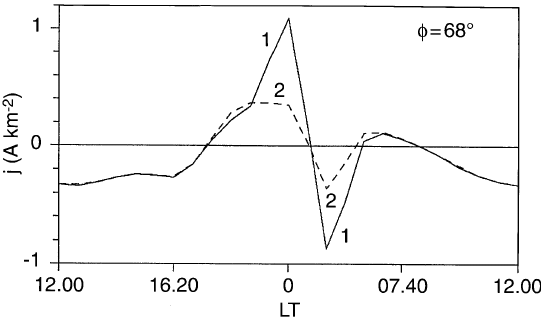
Fig. 4. The calculated longitudinal variations of the field-aligned current density along the 68 ° geomagnetic latitude in the end of the substorm expansion phase for the cases: (cid:49) , the region of decreased magnetospheric conductivity is travelling westwards and (cid:50) , it is at rest travelling speed (cid:86) (cid:116)(cid:114) of the decreased plamsa content region on the current wedge field-aligned current generation is opposite that of (cid:86) (cid:69) : the westward travelling of the ‘‘hole’’ acts as the eastward electromagnetic plasma drift.